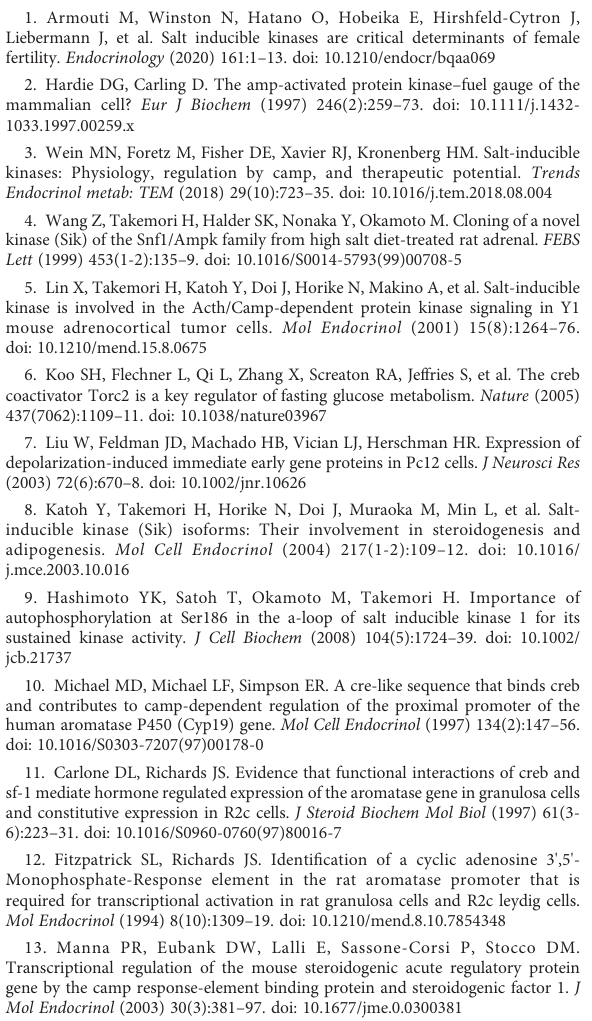
SUPPLEMENTARY FIGURE 3 Activation of EPAC does not affect SIK inhibition effects. Rat GCs were pretreated with vehicle or HG (0.5 µM) for one hour; then, cells were treated with vehicle, FSH, or 10 µM 8-CPT-cAMP (8CPT), an EPAC activator. Aromatase, StAR, and P450scc mRNA levels were determined 48 h after adding FSH or 8CPT. One-way ANOVA followed by Tukey. *p < 0.05, **p < 0.01, n =